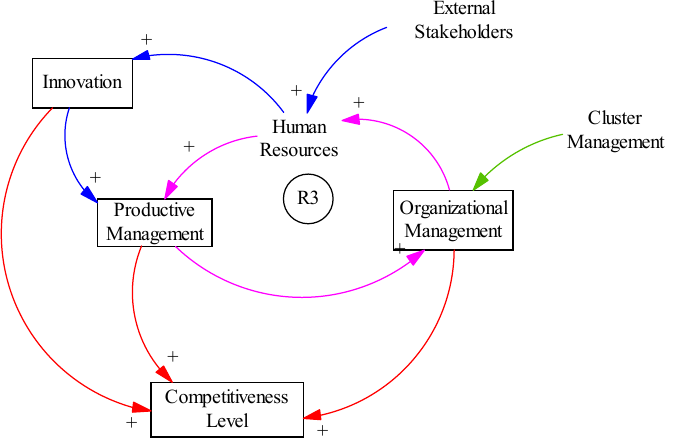
Figure 5. R3 Cycle: Productive Management, Organizational Management and Competitiveness Level.